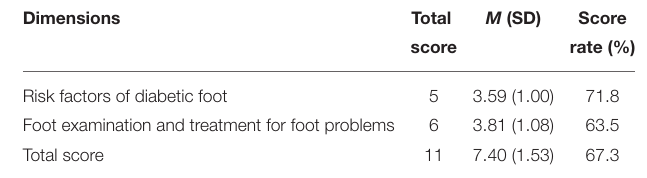
TABLE 2 | Knowledge scores of diabetic foot prevention.